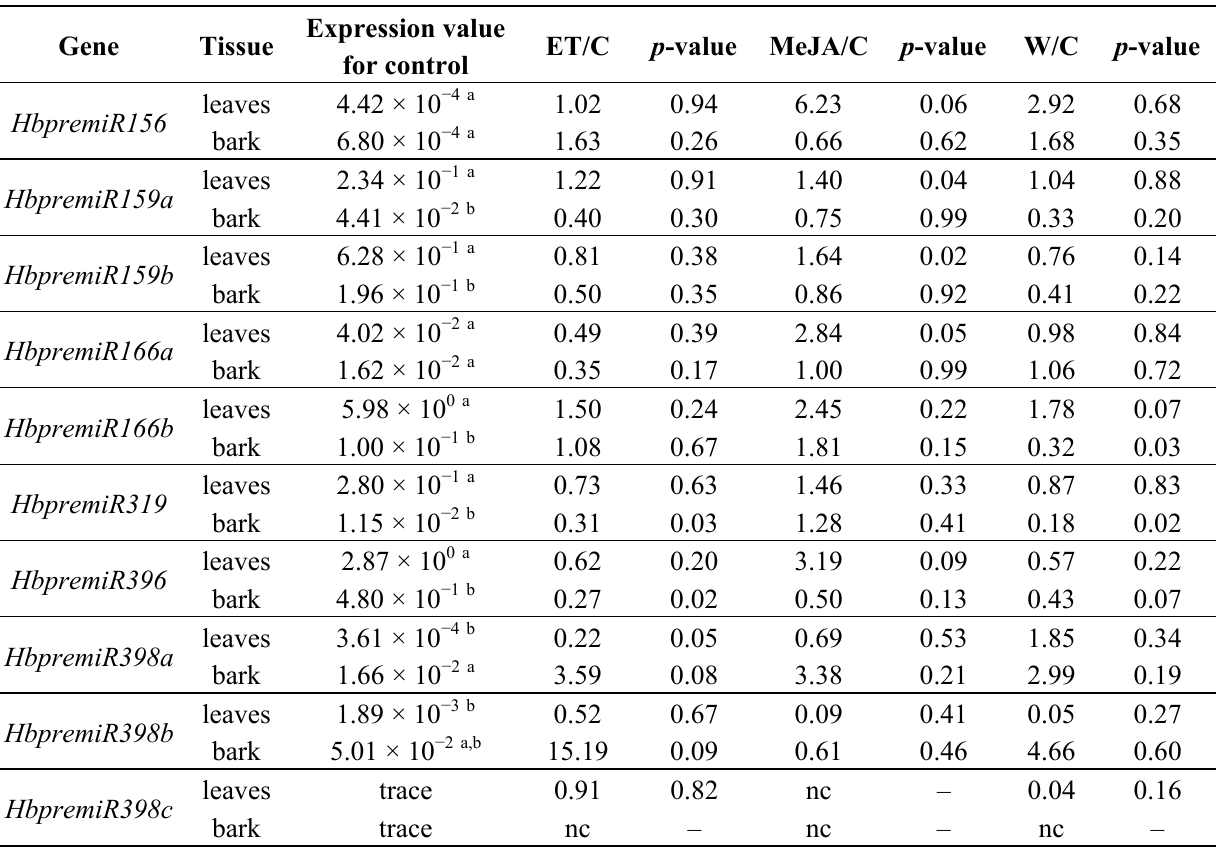
Table 2. Relative premiR abundance of 13 conserved MIR genes and 7 MIR genes newly identified in Hevea brasiliensis in the leaves and bark collected on 3-month-old epicormic shoot of budded plants in response to ethylene (ET), methyl jasmonate (MeJA) and wounding (W) compared with non-treated plants (C: control), nc: not calculated. Data with the same letter are not significantly different at the level of